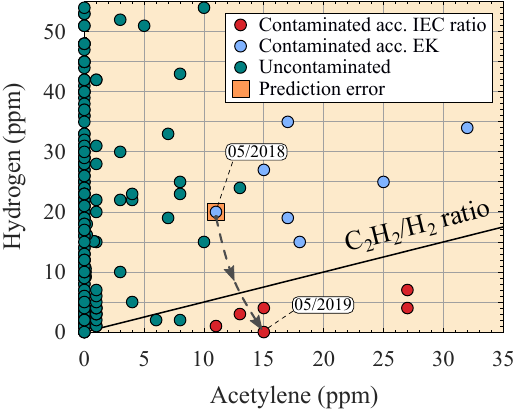
Figure 13. Transformer 4 responses and prediction